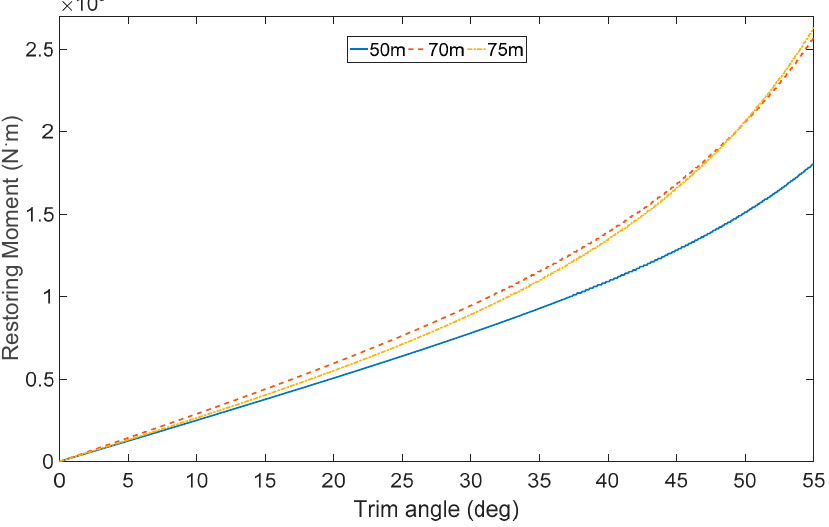
Figure 4. Articulated offshore wind turbines hydrostatic restoring moments via different trim angles.